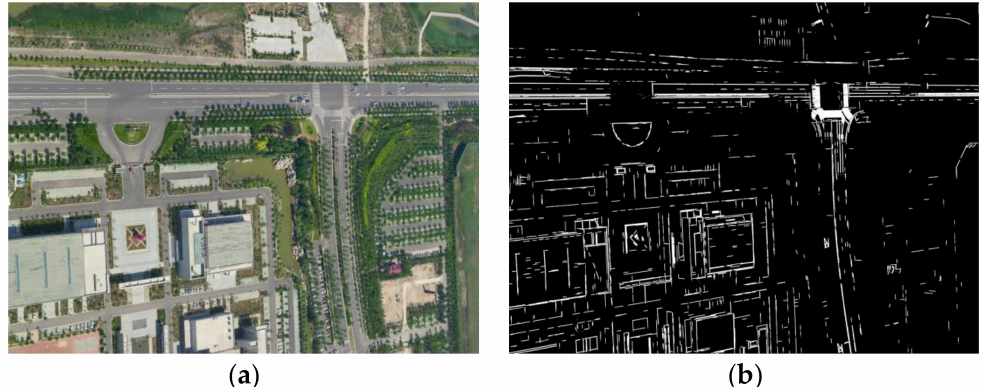
Figure 4. Extraction result of line feature. ( a ) Original oblique image and ( b ) extraction result of the line features (white parts, the gray value in the binary image is 255).